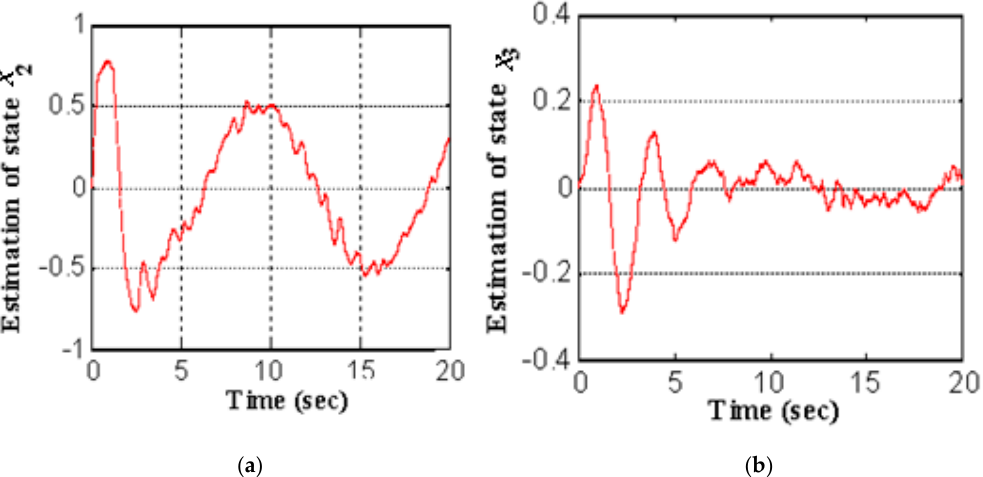
Figure 5. Estimated states using outer-loop LESO for the N-ADRC with measurement noise, ( a ) ˆz 2 , ( b ) ˆz 3 .